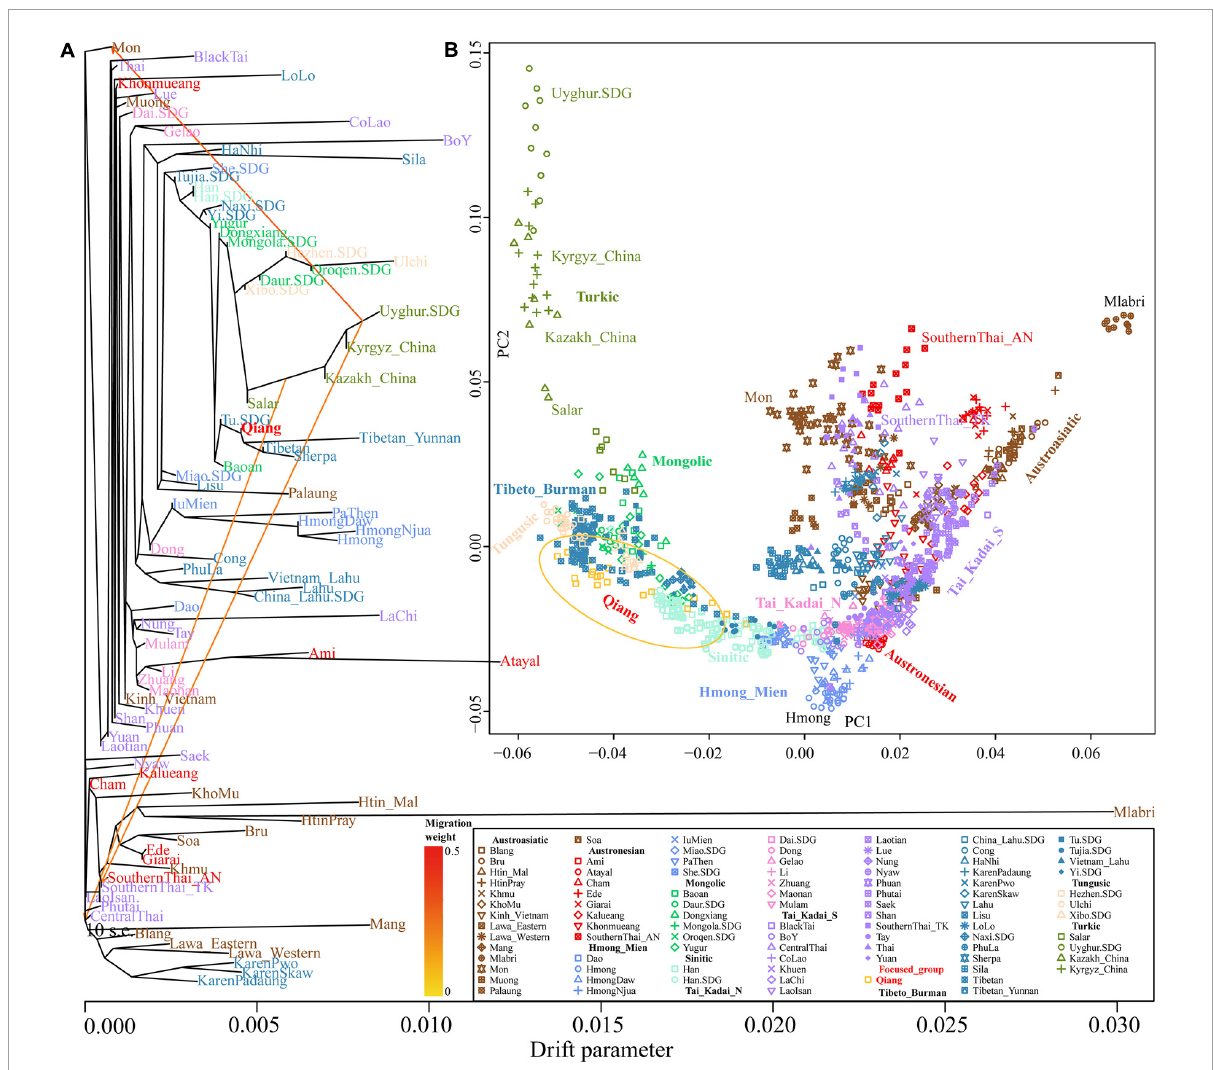
FIGURE10 TreeMix-based phylogenetic relationship between Qiang and other East Asians and PCA results of these batches of populations. (A) Phylogenetic relationship with three gene flow events showed the genetic relationship among Chinese populations. (B) Patterns of genetic variation inferred from PCA among Chinese populations. Populations from one language family were denoted with the same